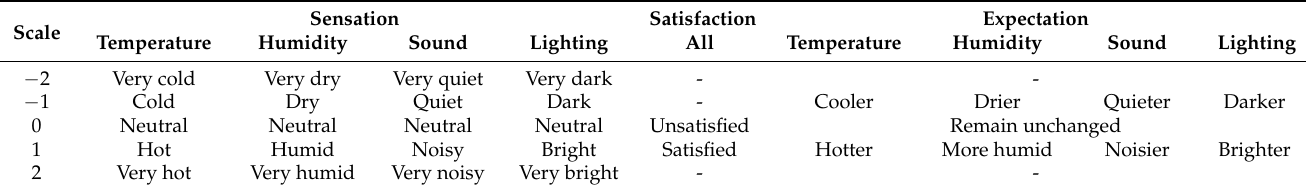
Table 2. Scales of the subjective perceptions.